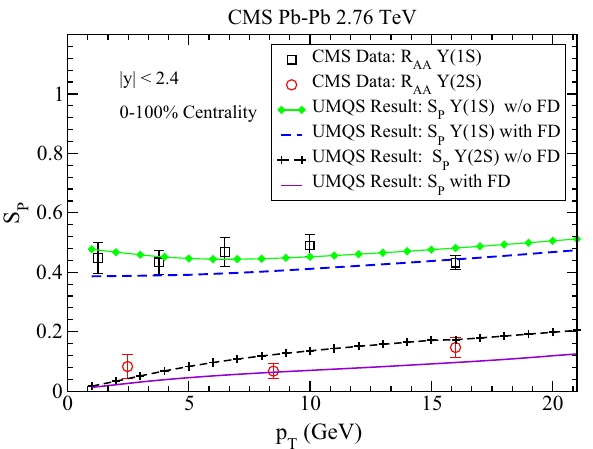
Fig. 8 Survival probability of ϒ( nS ) versus p T is compared with ϒ( nS ) nuclear modification factor R s NN = 2 . 76 TeV